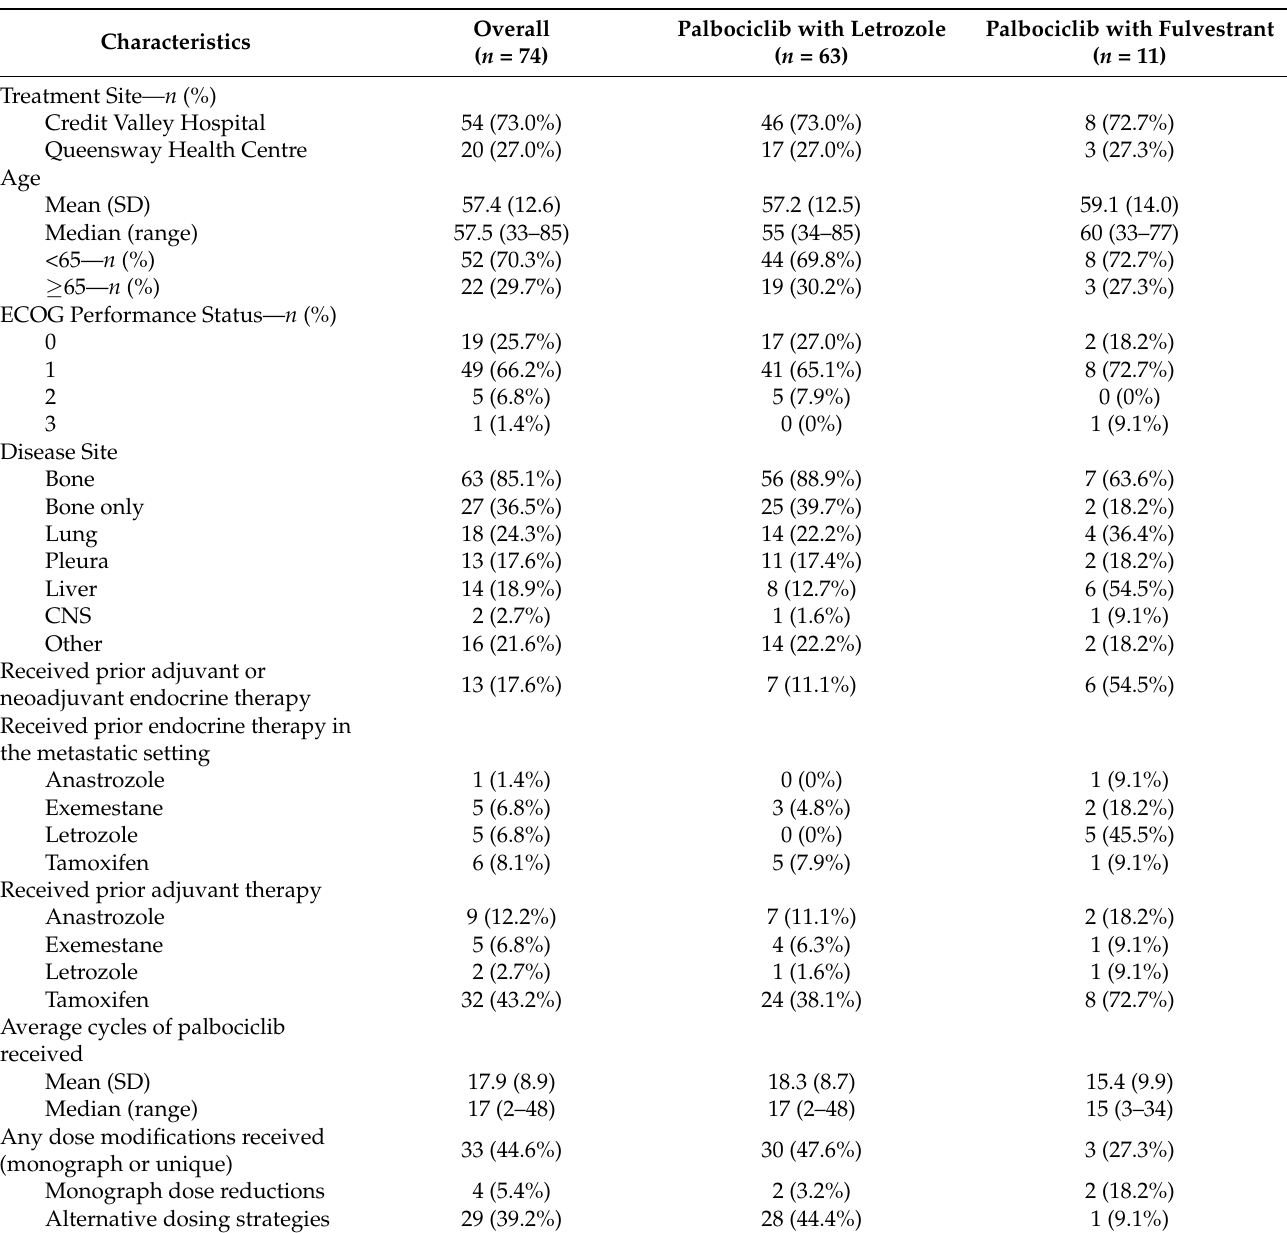
Table 1. Patient demographics and clinical characteristics.